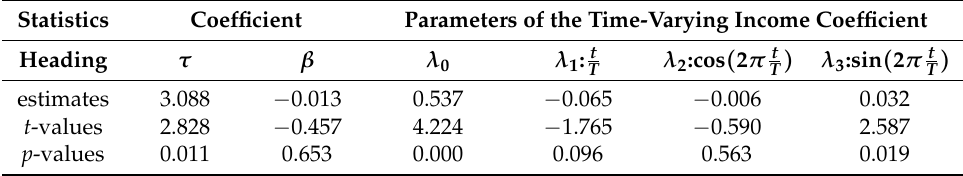
Table 3. Results of the Time-Varying Coefficient model.